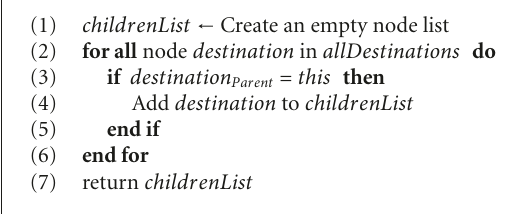
Algorithm 8: Finding Immediate Child Nodes in